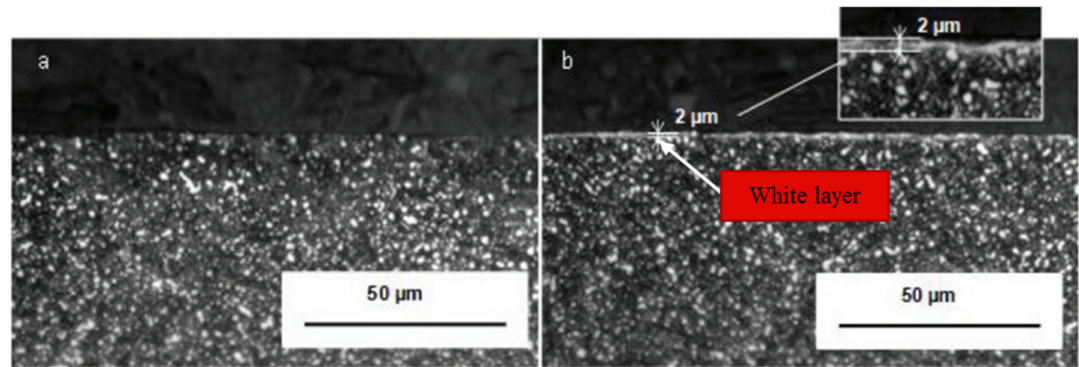
Figure 17. After turning with VNGA160408 (Negative). ( a ) Dry machining; ( b ) CO 2 machining, reprinted with permission from ref. [83]. Copyright 2015 Elsevier Ltd.